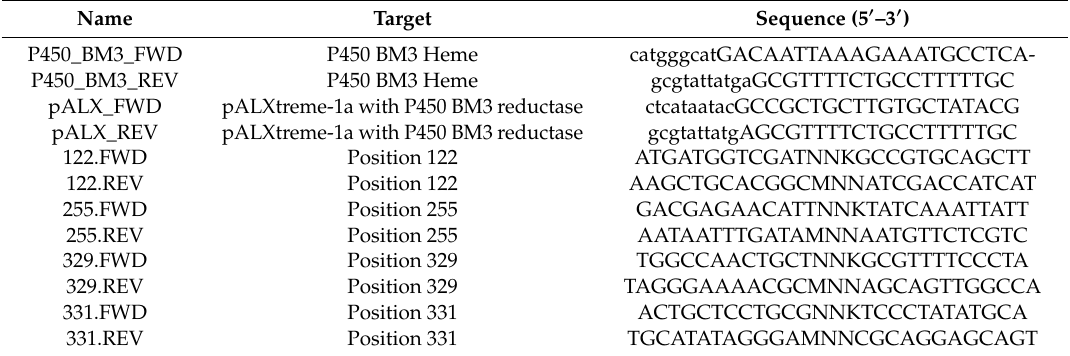
Table A1. List of oligonucleotides and primers used for cloning, sequencing, and mutagenesis during this work.